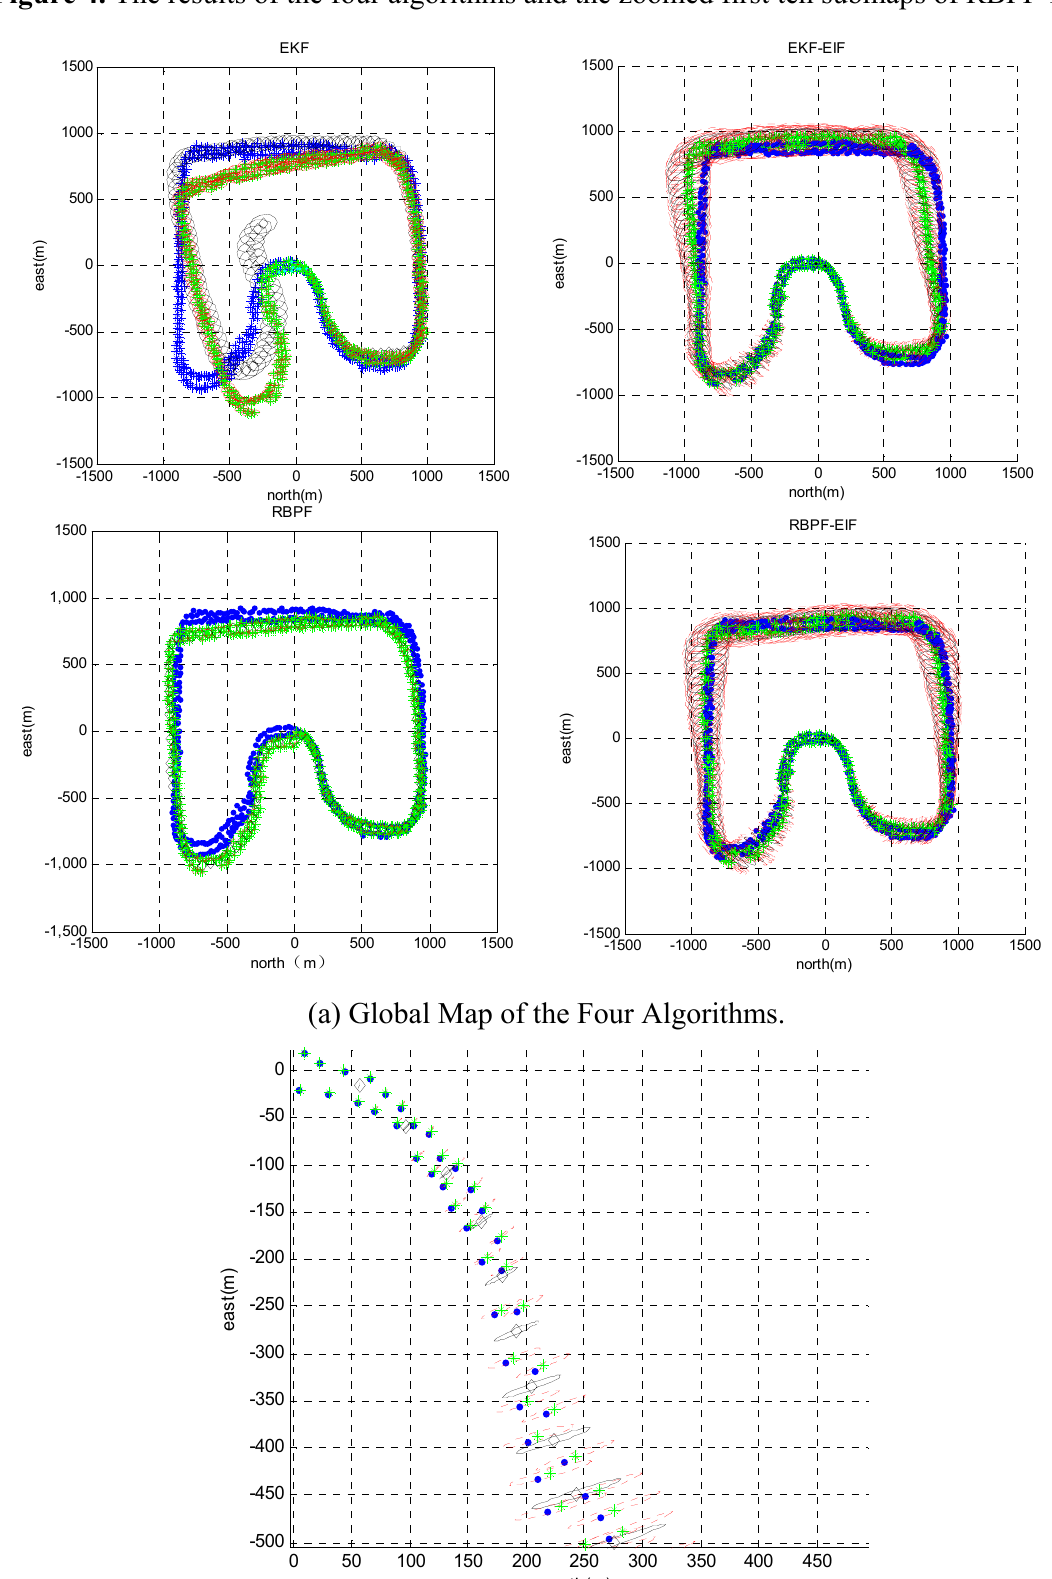
Figure 4. The results of the four algorithms and the zoomed first ten submaps of RBPF-EIF.